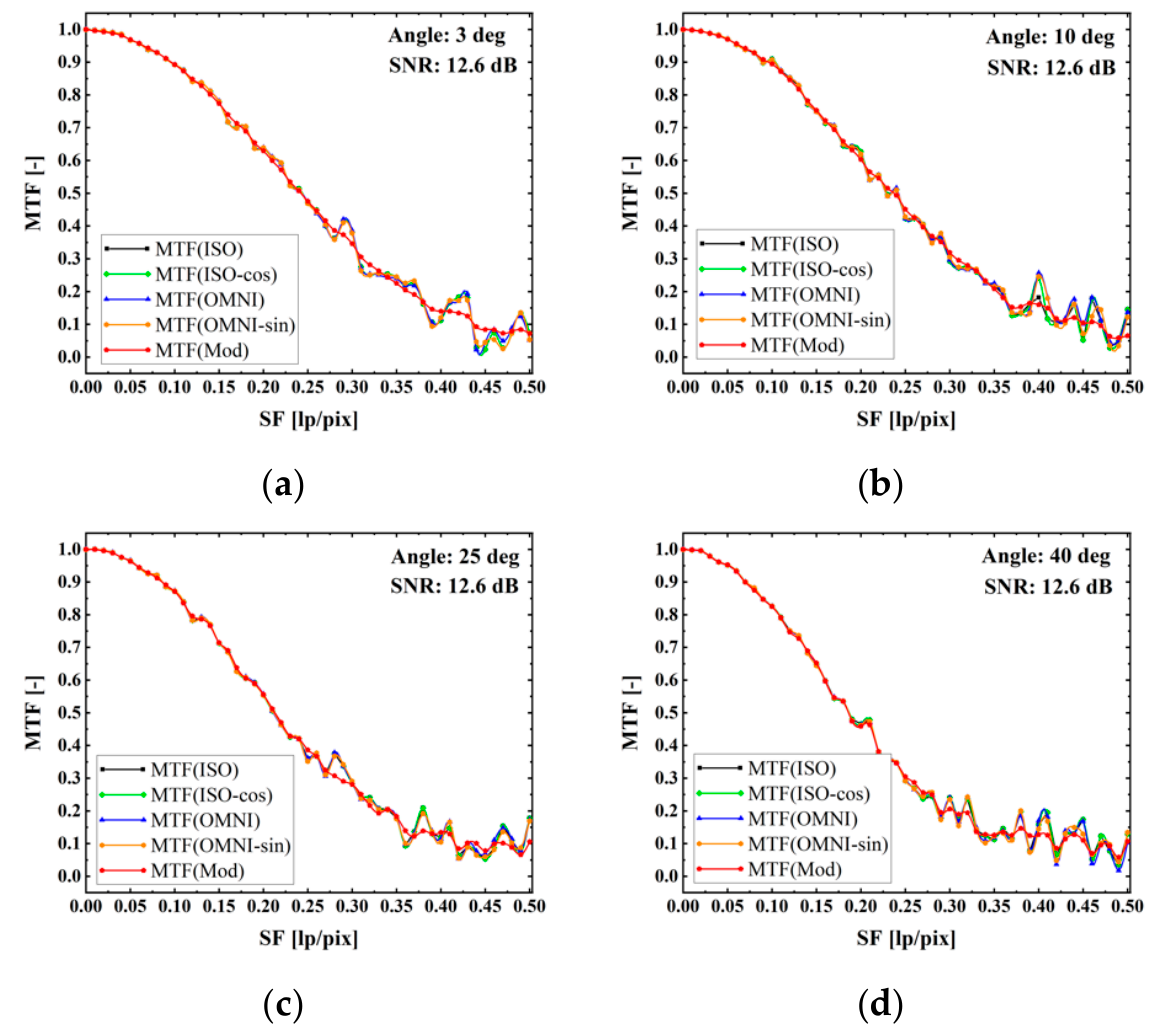
Figure 19. Simulation comparison: proposed method vs. other methods for BNDE images with different tilt angle: ( a ) when edge angle is 3 deg, ( b ) when edge angle is 10 deg, ( c ) when edge angle is 25 deg, ( d ) when edge angle is 40 deg.